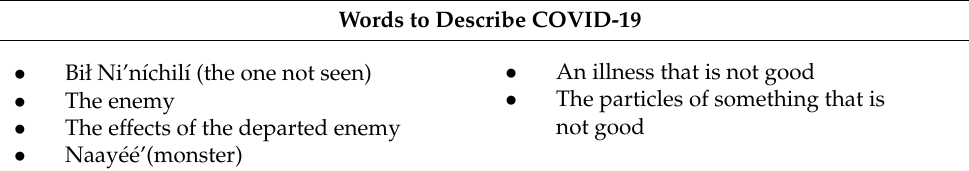
Table 2. How TKHs identified